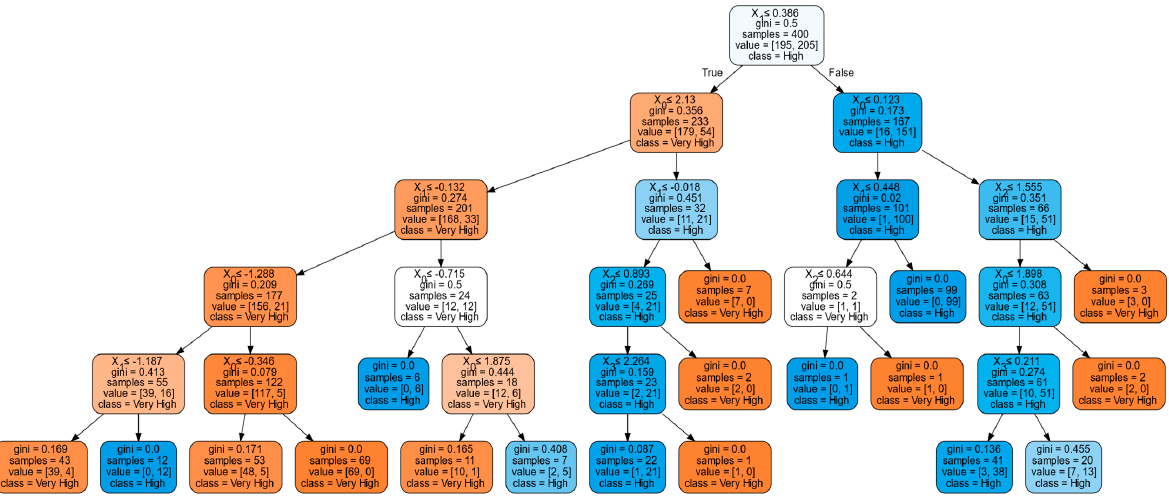
Figure 3. Optimum Random Forest